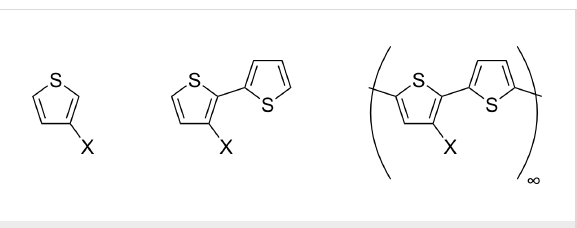
Figure 4: Illustration of the substitution patterns for singly bonded substituents of oligo- and polythiophenes considered in this study.